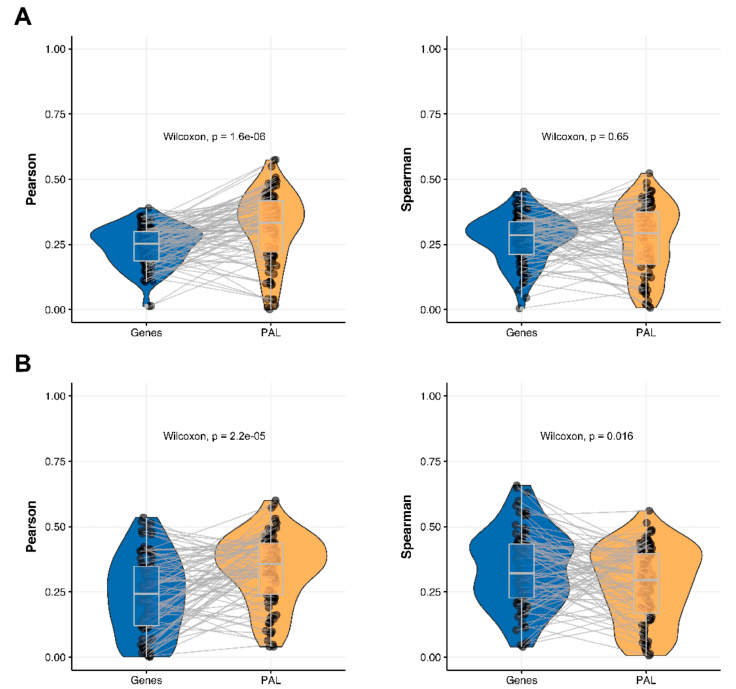
Figure 10. Paired gene-to-gene and PAL-to-PAL correlation between RNA and protein expression levels estimated within Uterine Corpus Endometrial Carcinoma biosamples using Pearson ( left ) and Spearman ( right ) correlation coefficients for ( A ) the total set of genes and molecular pathways; ( B ) the set of drug target genes and molecular pathways